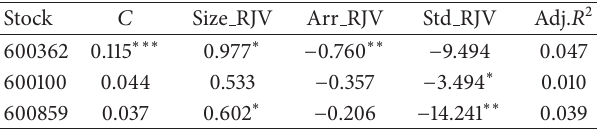
Table 5: Forecasting one-month-ahead individual stock returns using realized jump volatility-based factor